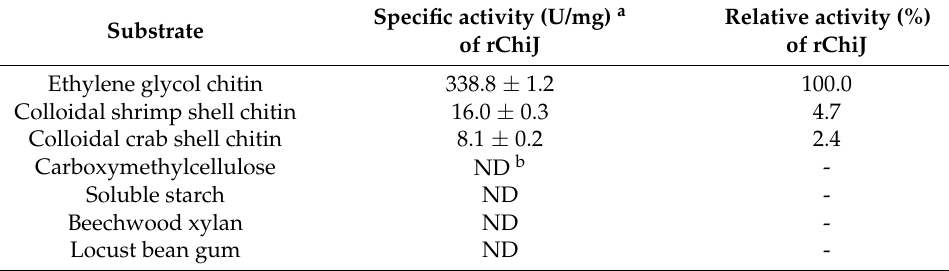
Table 2. Biocatalytic activity of rChiJ for different